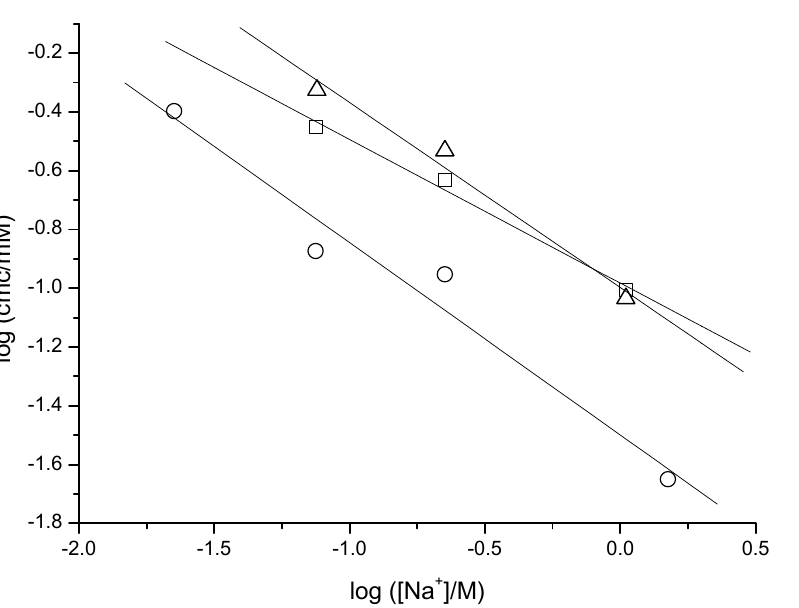
Figure 3. Dependence of cmc with the counterion concentration (Corrin–Harkins equation) for NaAdC (squares), NaAdCH 2 C (triangles), and Na t butPhC (circles).